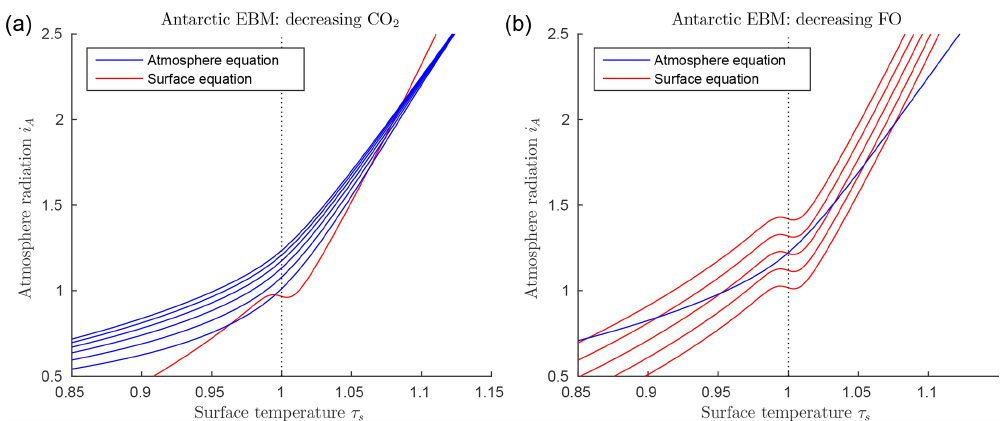
Figure 5. EBM for the glaciation of Antarctica (with δ = 0 . 67, F A = 45Wm − 2 , Q = 173 . 2Wm − 2 , α W = 0 . 15, Z = 9 km). (a) Graphs of EBM equations, with F O fixed at 90Wm − 2 in the surface equation (red line), and with CO 2 concentration µ in the atmosphere equation increasing (from bottom to top blue lines) µ = 200 , 400 , 600 , 800 , 1000 and 1200ppm. (b) Graphs of the same EBM equations but with CO 2 concentration µ fixed at 1100ppm (blue line) and with ocean heat transport F O decreasing (from bottom to top red lines) 80, 60, 40, 20 and 0Wm − 2 .